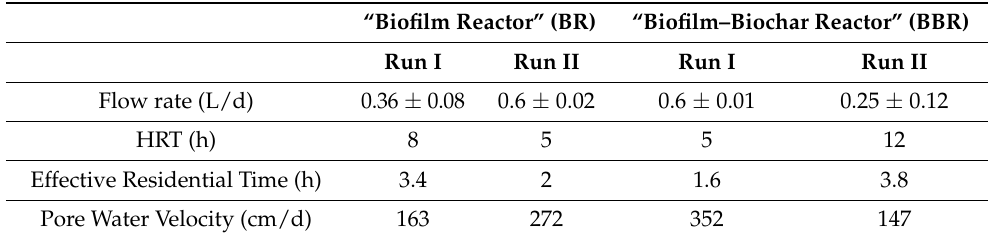
Table 1. Experimental operating conditions of the BR and